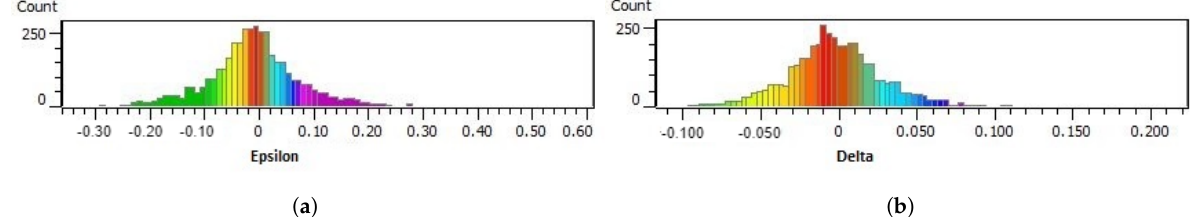
Figure 22. The histograms of the anisotropy parameters ( a ) Epsilon and ( b ) Delta sections, which were calculated by applying the MLFN-based Z P and Z S to the impedance-domain Thomsen’s anisotropy equations.